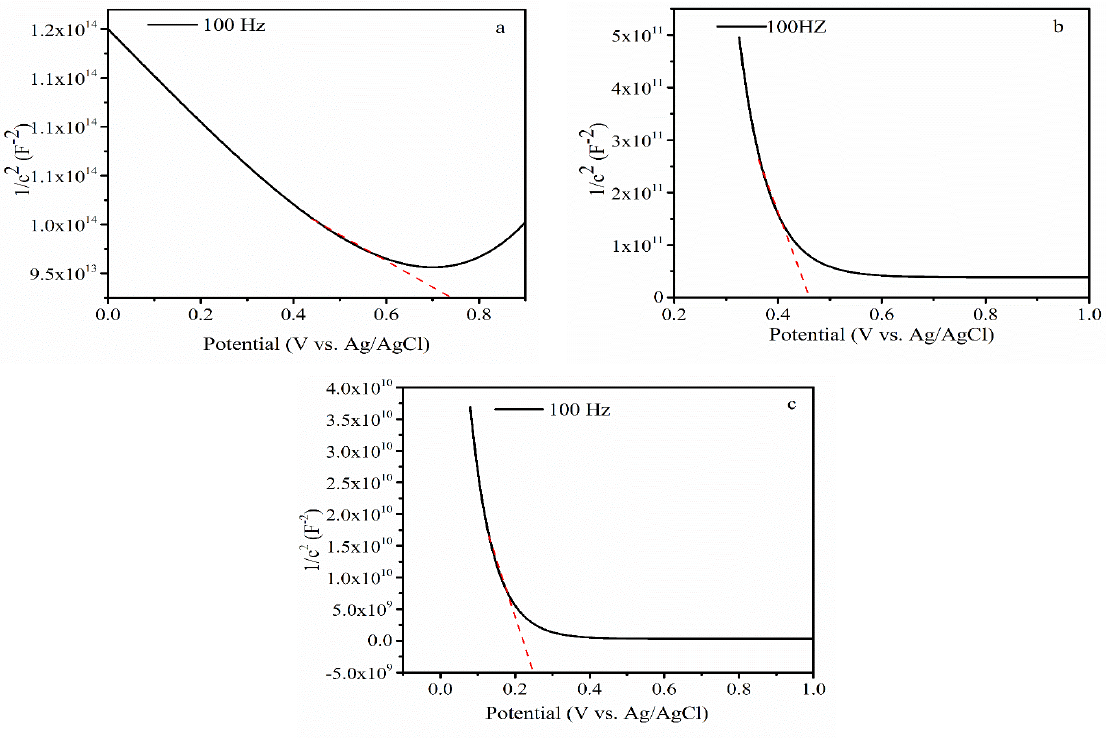
Figure 7: Mott-Schottky plots at frequency of 100Hz in the dark of the (a) p-Si(100), (b) SiNWs photocathode prepared by etching time of 15 min and (c) SiNWs photocathode prepared by etching 30